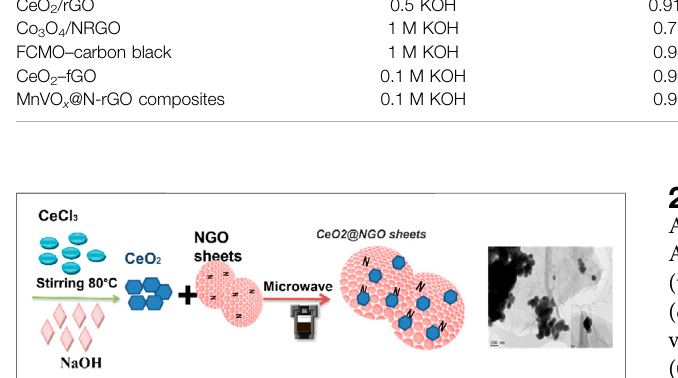
OER, E Onset (V vs. RHE) (V vs.